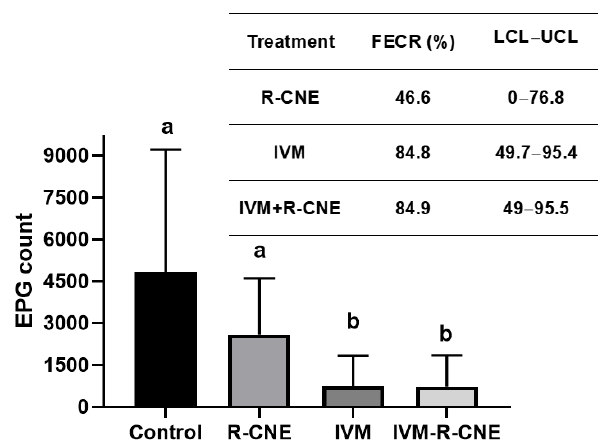
Figure 2. Mean ( ± SD) egg counts per gram of feces (EPG) obtained at 15 days for untreated control lambs ( n = 8) and those treated subcutaneously with ivermectin (IVM) (0.2 mg/kg, n = 9) either alone or in combination with carvone (R-CNE) (three oral doses of 100 mg/kg every 24 h, n = 9). The inset shows the fecal egg count reduction (FECR) with the upper (UCL) and lower (LCL) confidence limits in lambs naturally infected with IVM-resistant nematodes. Different letters denote statistically different values compared to control group at p ≤ 0.05.